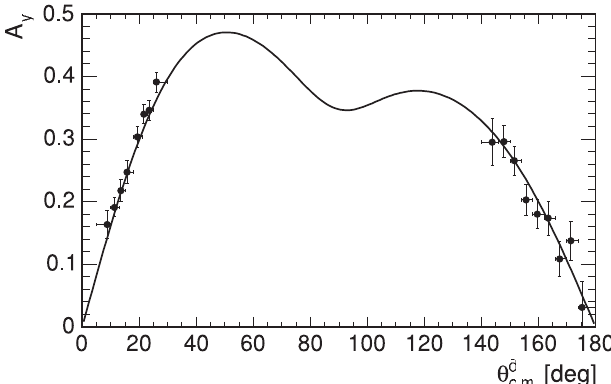
FIG. 9. Analyzing power of the ~np ! d(cid:1) 0 reaction measured at ANKE compared to the curve of values of A as extracted from the SAID data base [39] (for numerical values, see Table II).